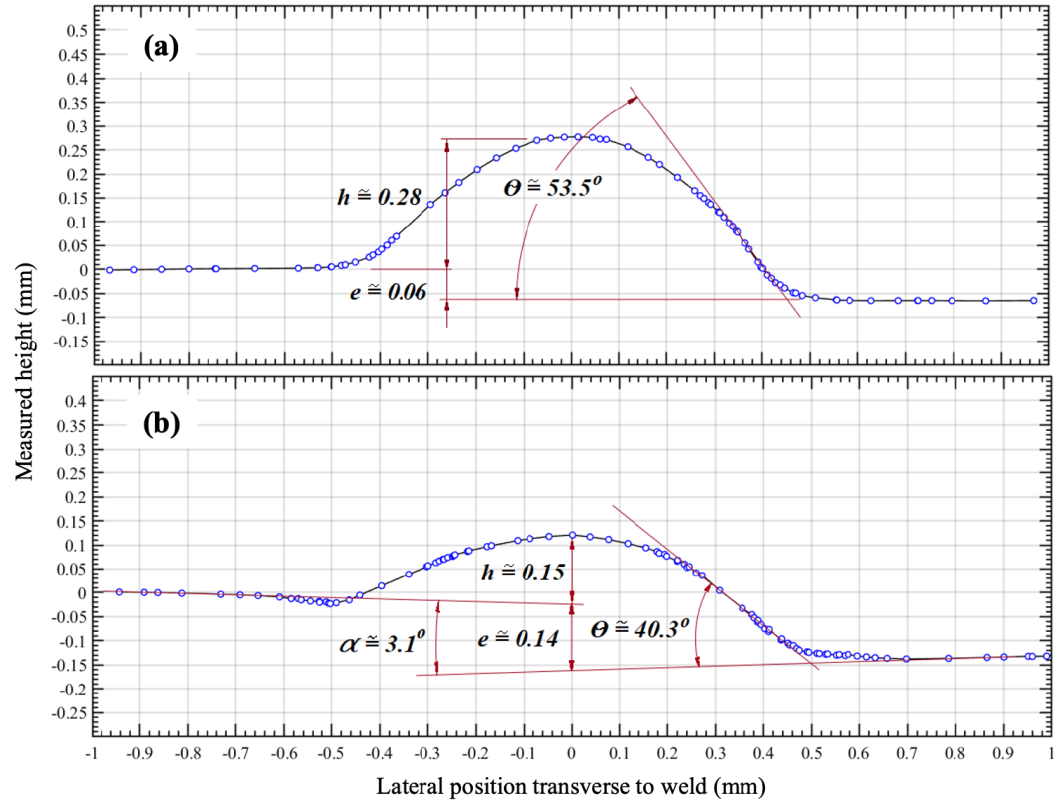
Figure 6. Profilometric measurements across selected laser weld seams: ( a ) NbMo modified steel specimen and ( b ) standard steel specimen before flush grinding.